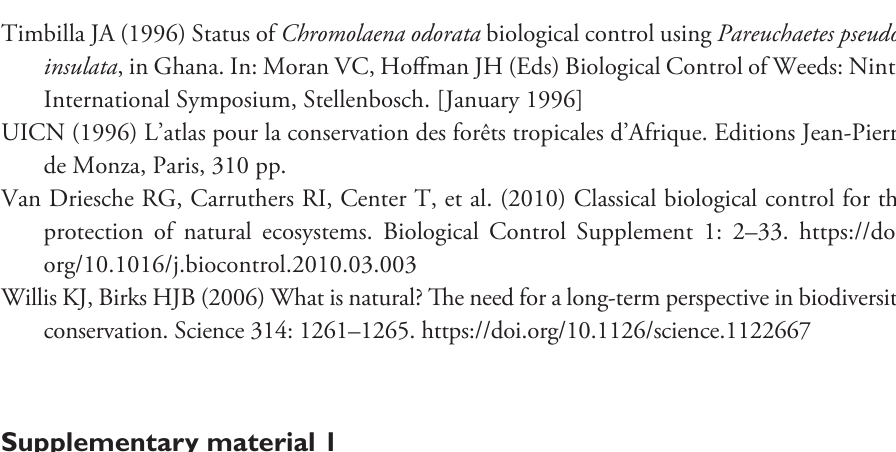
Table A. Comprehensive list of all plant species of Drabo Gbo,